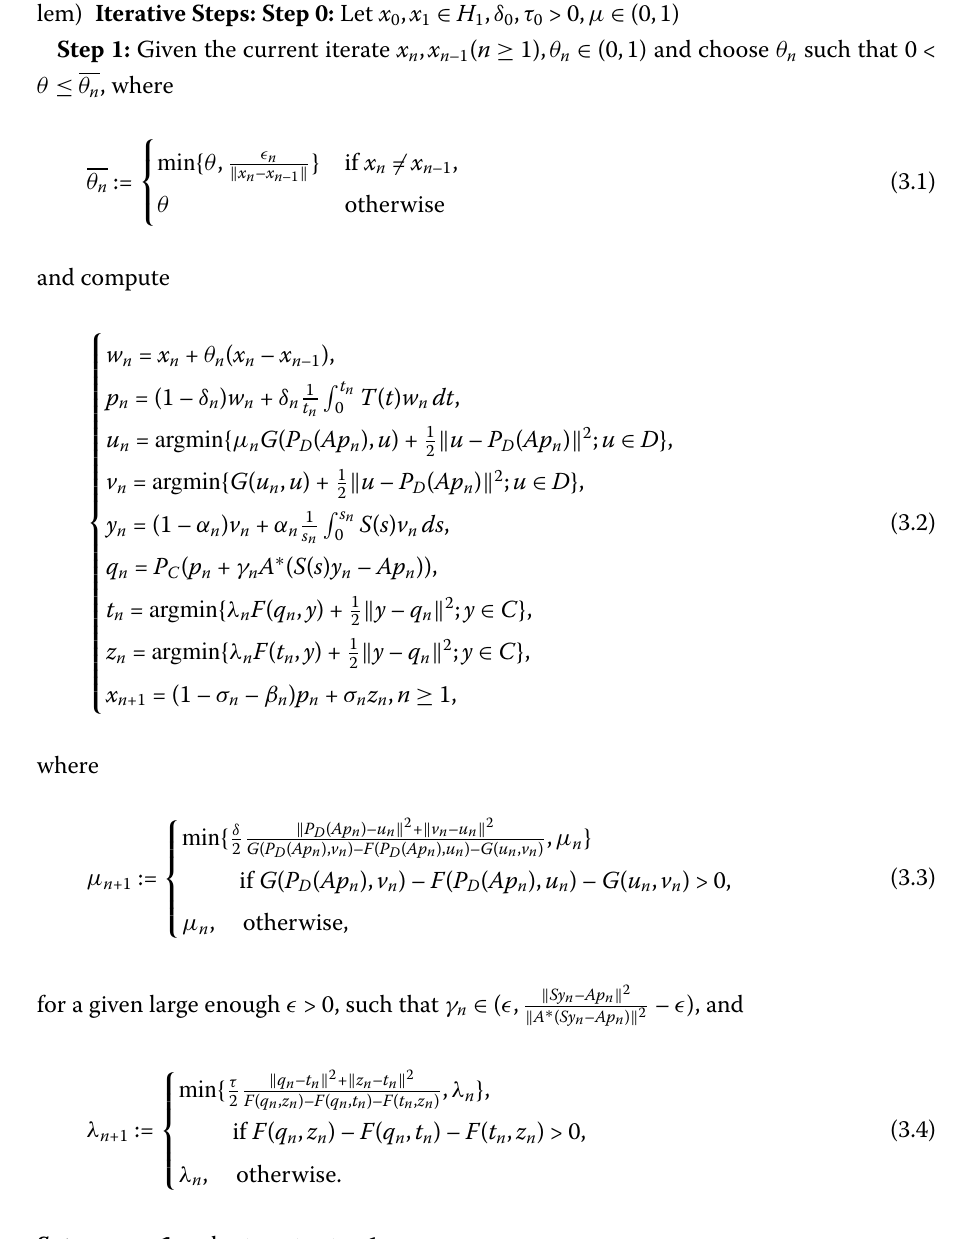
Algorithm 3.3 (Self-Adaptive Inertial Extragradient Method for Split-Equilibrium